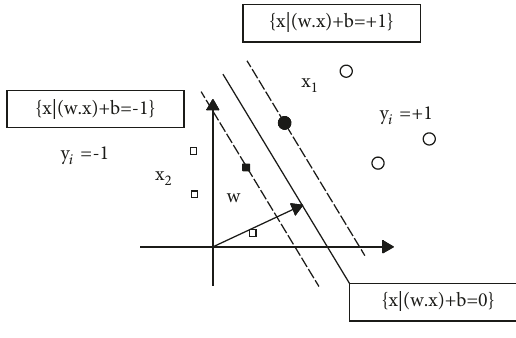
Figure 1: Classification of data by